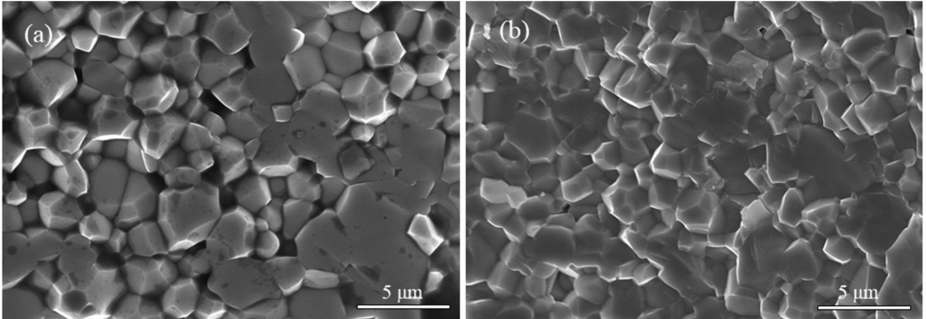
Figure 3. SEM pictures of the cross-section for CaCu 3 Ti 4 O 12 ( a ) and La 2/3 Cu 3 Ti 4 O 12 ( b )